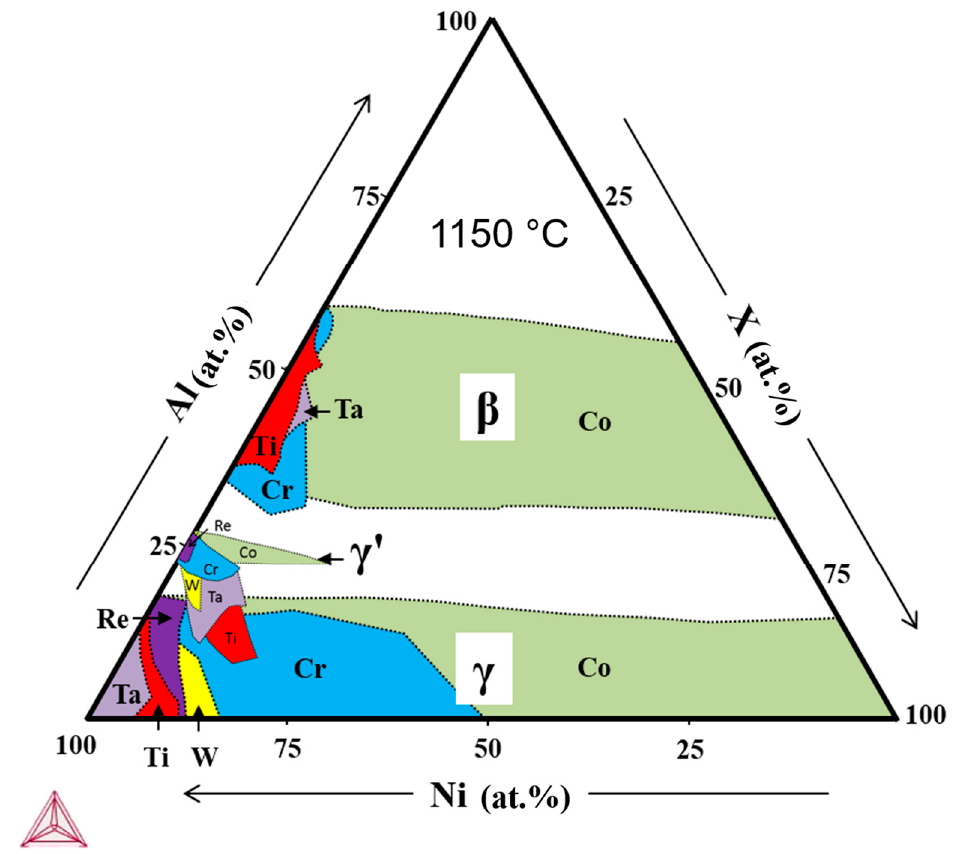
Figure 12. Ni-Al-X ternary phase diagrams (overlayed) at 1150 °C.